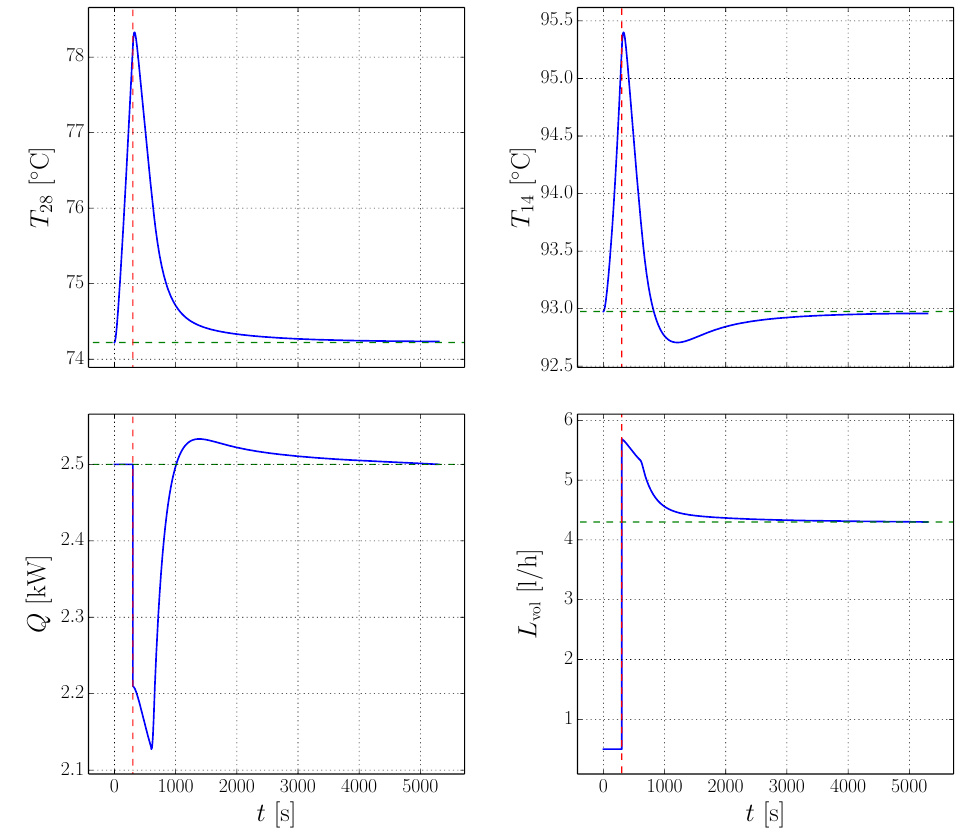
Figure 5. Control of a distillation column after a reflux breakdown. The vertical dashed lines mark the end of the breakdown, after which the optimal control starts. The horizontal dashed lines mark the reference values, which is the steady state before